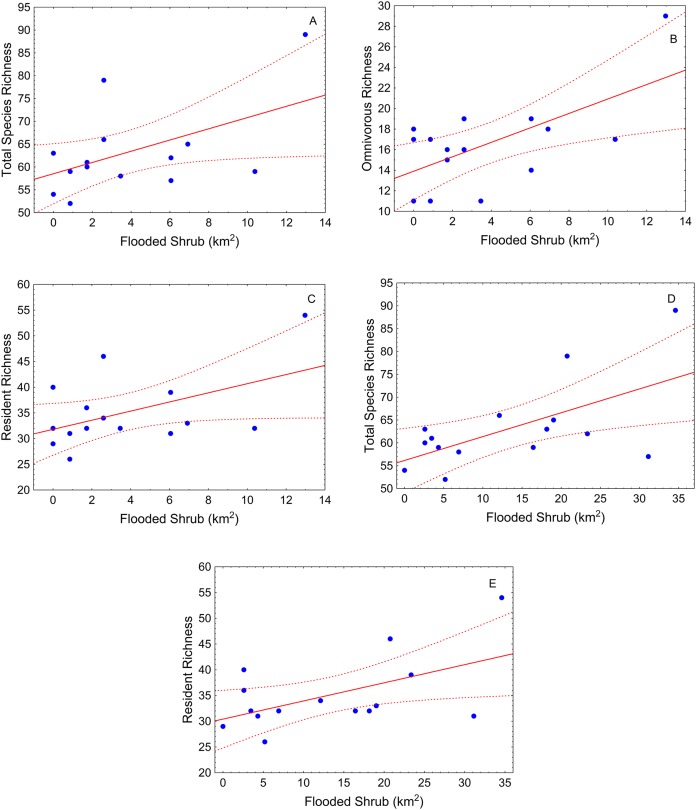
Scatter-plots by buffer and high-water season.At 500 m—(A) total species richness vs. flooded shrub; (B) omnivorous richness vs. flooded shrub; (C) resident richness vs. flooded shrub; 1,000 m—(D) Total sp vs. flooded and (E) resident richness vs. flooded shrub. Tendency lines for the models with significative independent variables, where points are observed values of species richness per site, full lines are fitted lines and dotted lines are confidence intervals at 95%.